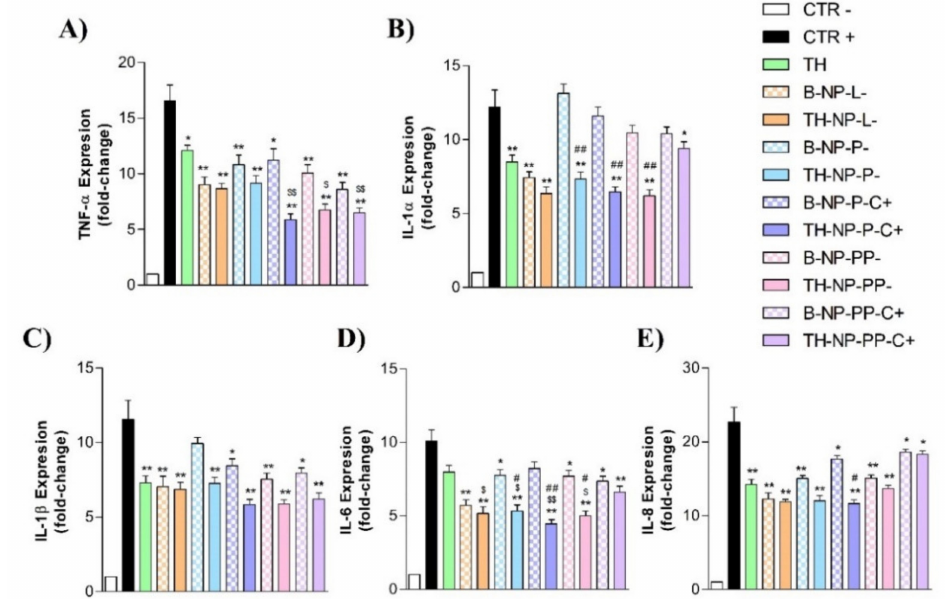
Figure 9. Gene expression levels of inflammatory cytokines in C. acnes -infected HaCaT cells. Before the addition of undiluted C. acnes inoculum (adjusted to OD 1.2 at 550 nm), HaCaT cells were pre-incubated with TH or the indicated NPs. Relative mRNA levels of ( A ) IL-6, ( B ) IL-8, ( C ) IL-1 α , ( D ) IL-1 β and ( E ) TNF- α were measured by RT-qPCR, using β -actin as the reference gene. Values (Mean ± SEM, n = 3) are expressed as fold-change compared to untreated HaCaT cells (control-). Statistical analysis was performed via one-way ANOVA, followed by Tukey’s Multiple Comparison Test ( p < 0.05* or p < 0.001**): versus positive control (control+); ( p < 0.05 $ or p < 0.001 $$ ): versus TH and ( p < 0.05 # or p < 0.001 ## ): versus the respective